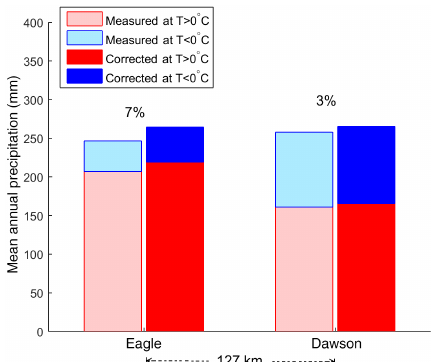
Figure 9. Mean annual (2006–2013) measured and corrected pre- cipitation for cold ( T <0 ◦ C) and warm ( T >0 ◦ C) months. The per- centages are the change from measured to corrected precipitation. The approximate horizontal distance between the stations is dis- played at the bottom.